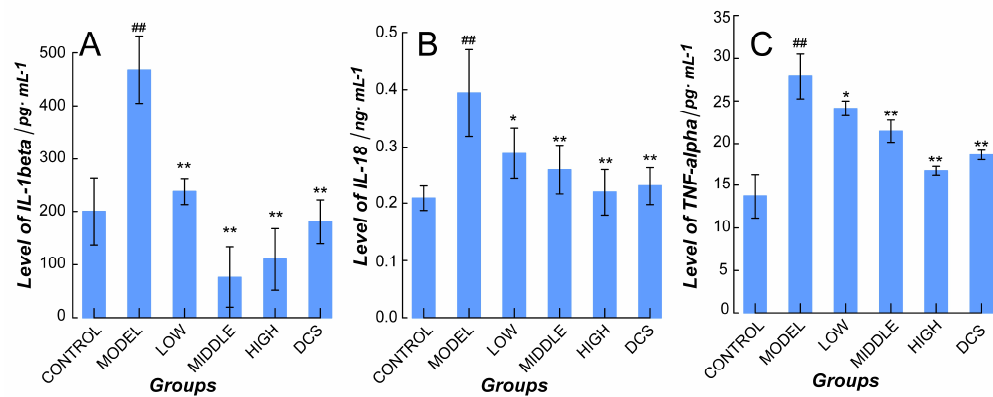
Figure 4. Quantification of plasma cytokines related with NF-κB and NLRP3/Caspase-1 pathways in all CIA murine groups. ( A ) IL-1β, ( B ) IL-18, ( C ) TNF-α levels in all groups. DCS, Diclofenac sodium. ## p < 0.01 vs. Control. * p < 0.05 vs. Model. ** p < 0.01 vs. Model.